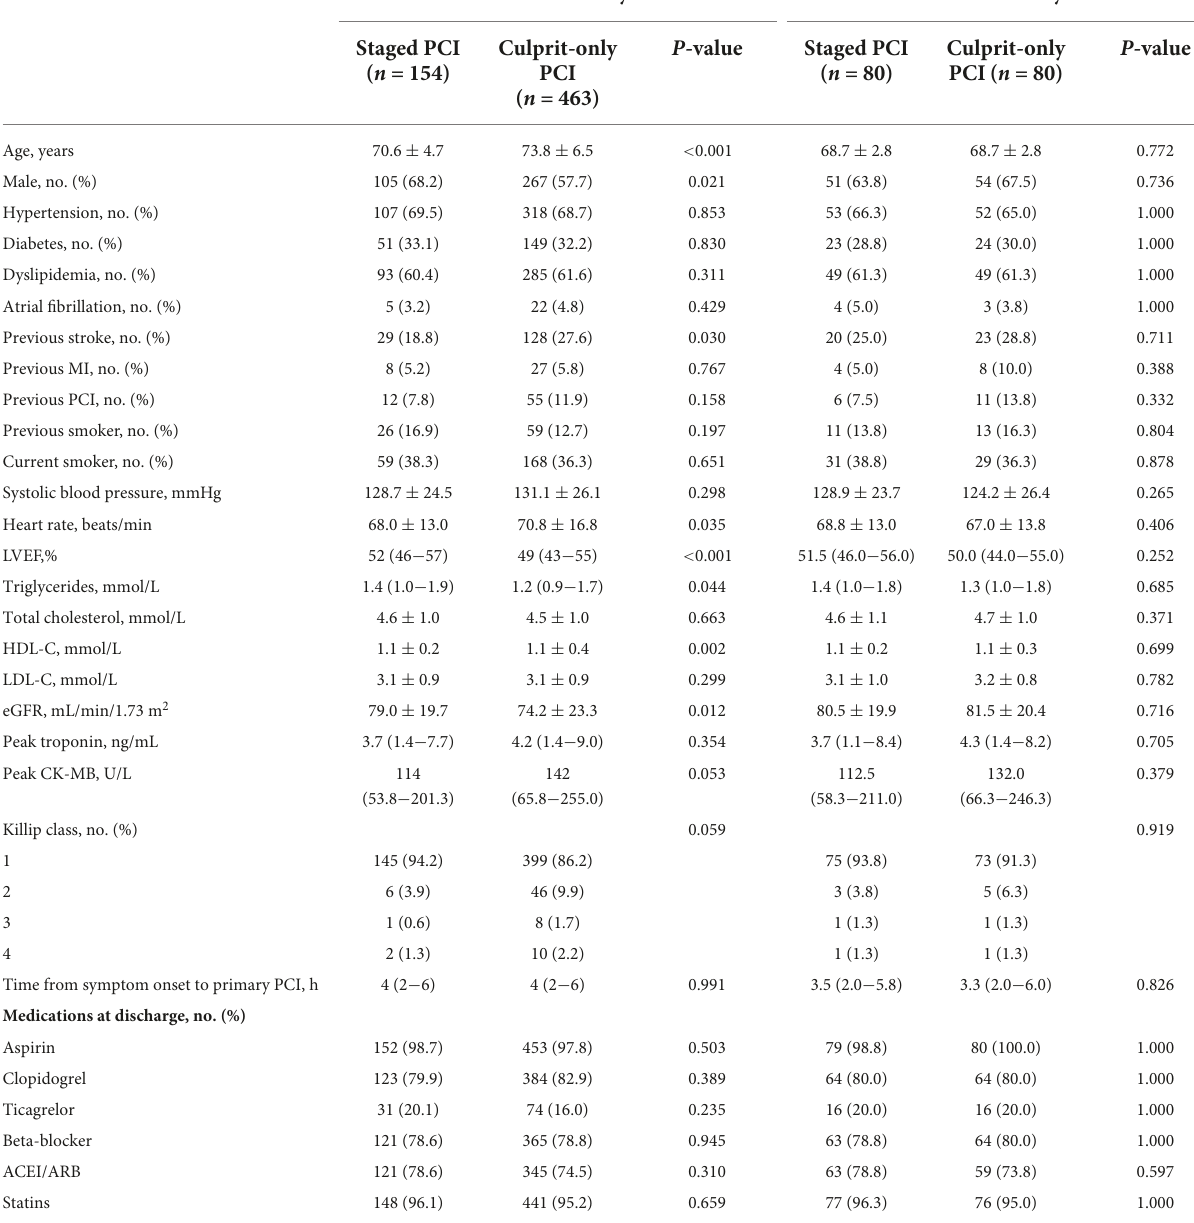
TABLE 1 Baseline characteristics of included patients before and after propensity score matching (PSM). Characteristic Before PSM